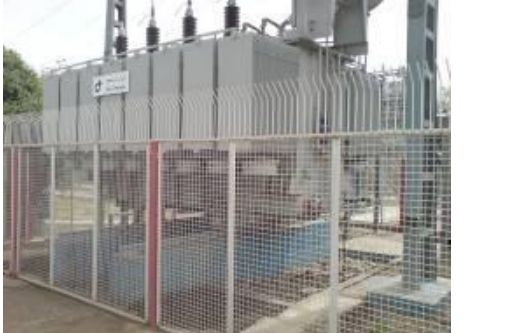
Figure 6. Power Transformer of 63 KV substation of Qazvin 1